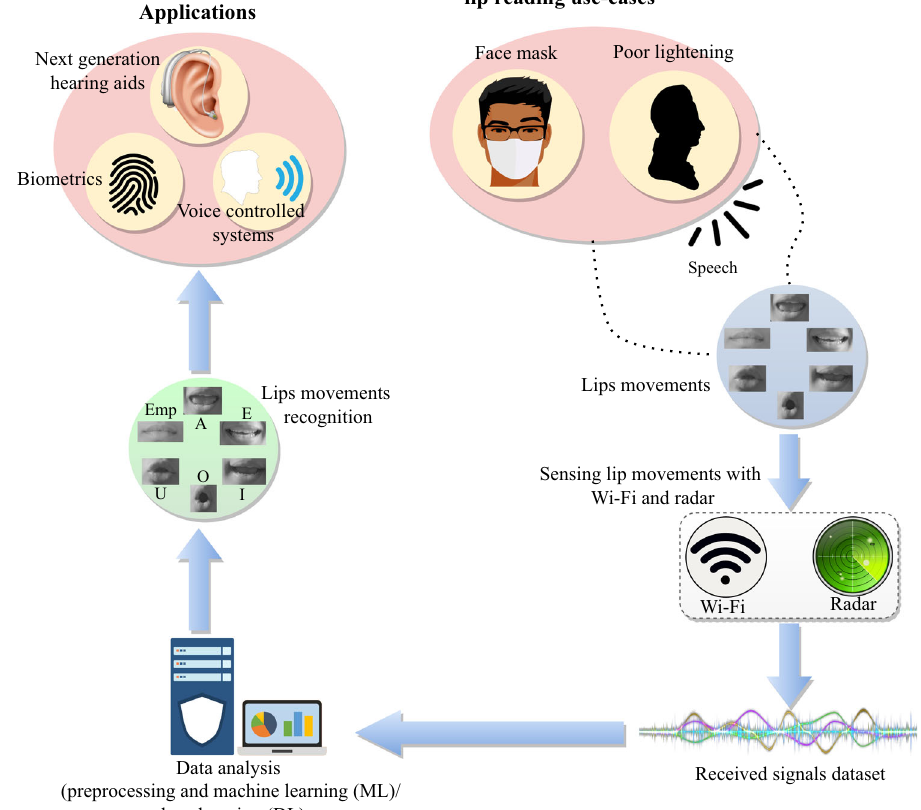
Fig. 1 | Conceptual illustration of the proposed Lip-reading framework. The framework employs Wi-Fi and radar technologies as enablers of RF sensing based Lip-reading. A dataset comprising of vowels A, E, I, O, U and empty (static/closed